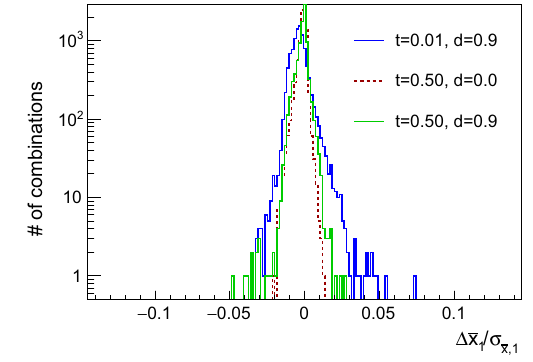
Fig. 7 Difference between the combined value of ¯ x 1 obtained with the method described here and using a direct likelihood combination rela- tive to the total uncertainty of ¯ x 1 . The distribution is shown for different valuesofthescale t forsystematicuncertaintiesandthestatisticalcorre- lationbetweentheestimates d .Thecombinationassumesnocorrelation between the uncertainties of both pseudo-measurements